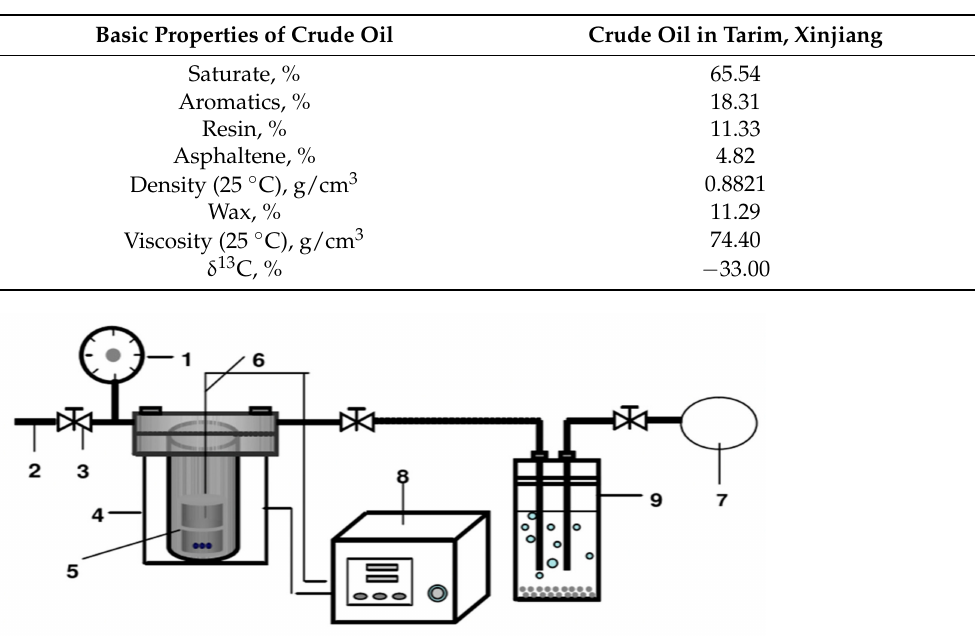
Figure 2. Pyrolysis experimental apparatus [40]. 1—pressure gauge; 2—air intakes; 3—intake